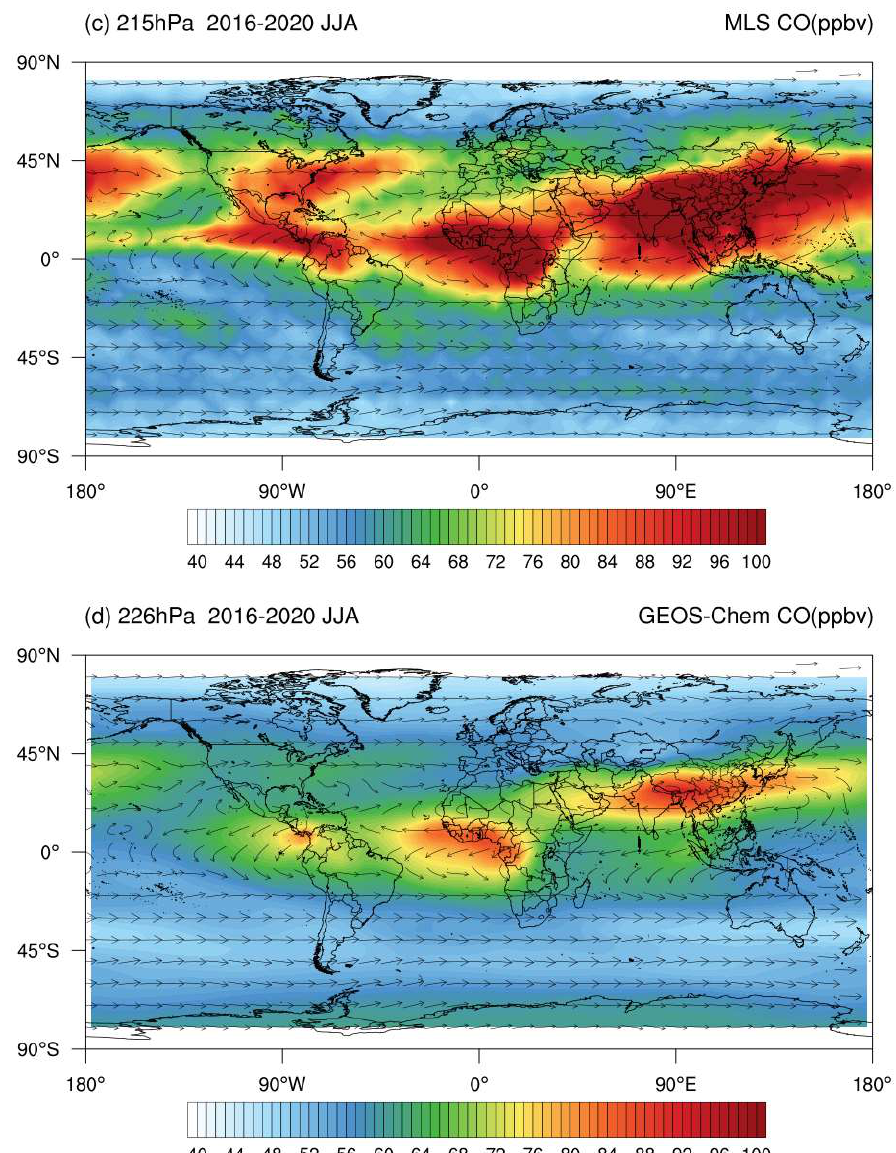
Figure 3. Comparison of the observed CO values in the UTLS region to the simulated values. ( a ) MLS observation of the CO distribution at 100 hPa. ( b ) GEOS-Chem simulated CO distribution at 100 hPa. ( c ) MLS observation of the CO distribution at 215 hPa. ( d ) GEOS-Chem simulated CO distribution at 225 hPa. Units: ppbv. MERRA-2 reanalysis data are used for the wind field.